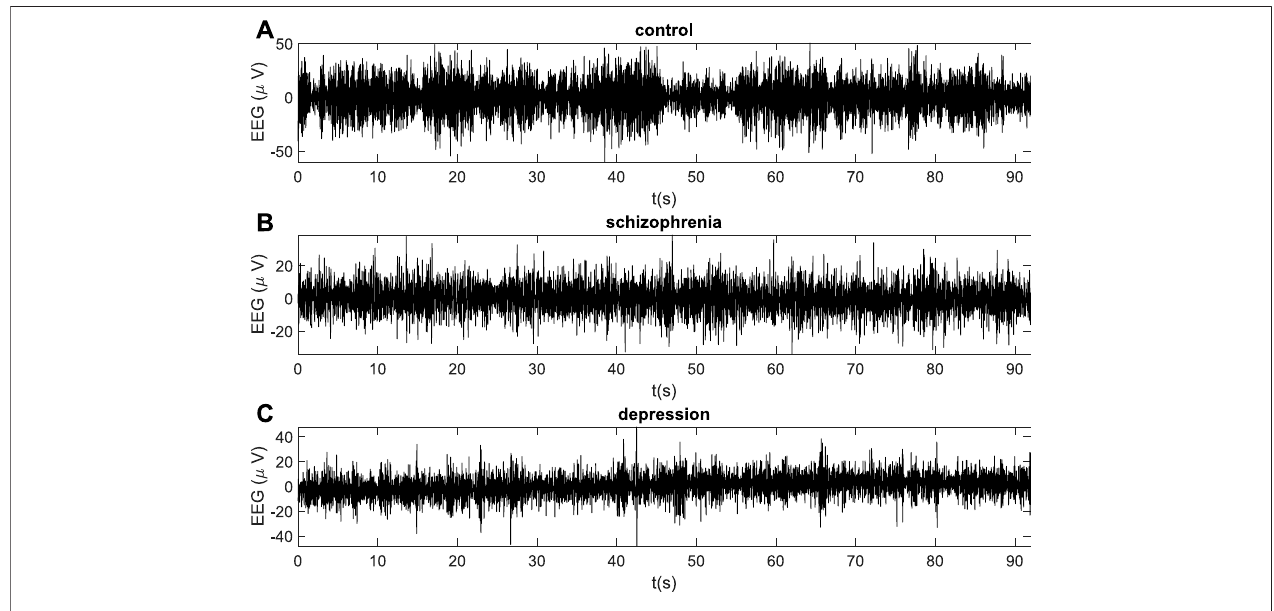
FIGURE 1 | The examples of EEG recordings for the healthy subject (A) , the patient with schizophrenia (B) and the patient with depression (C) (O2 site).